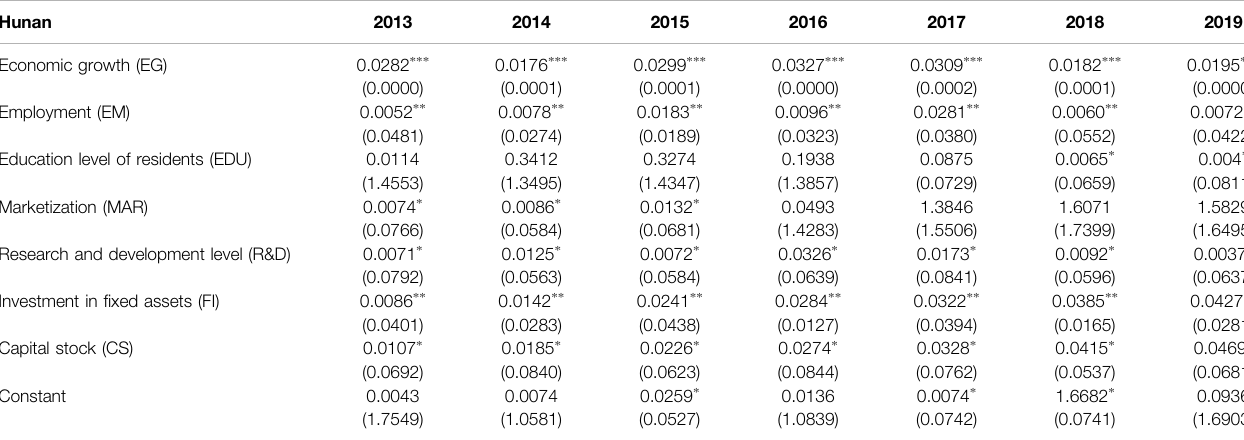
TABLE 10 | Driving force of Hunan health tourism industry convergence